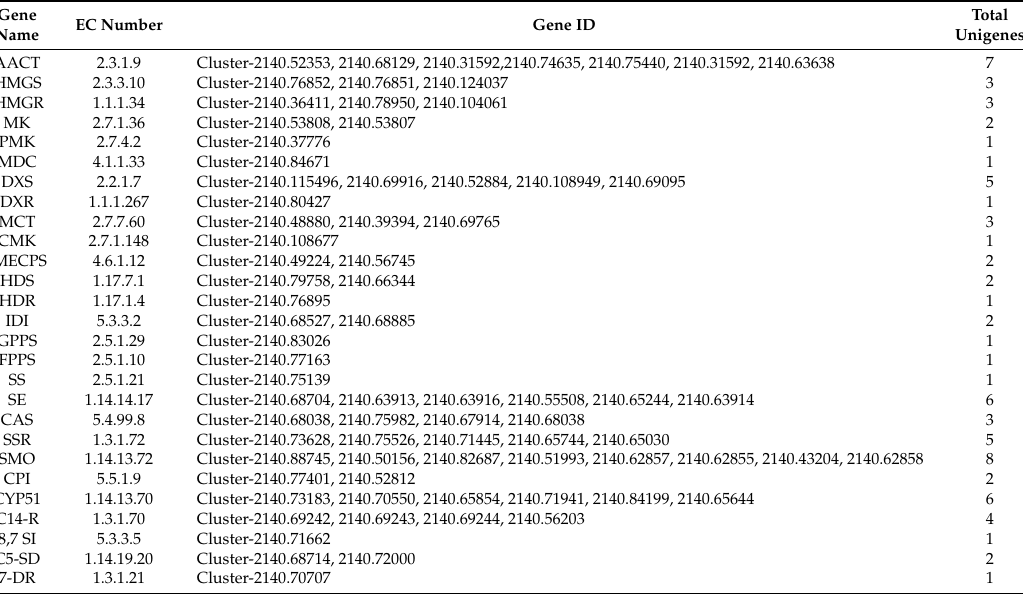
Table 3. Putative genes involved in cholesterol biosynthesis in T. foenumgraecum